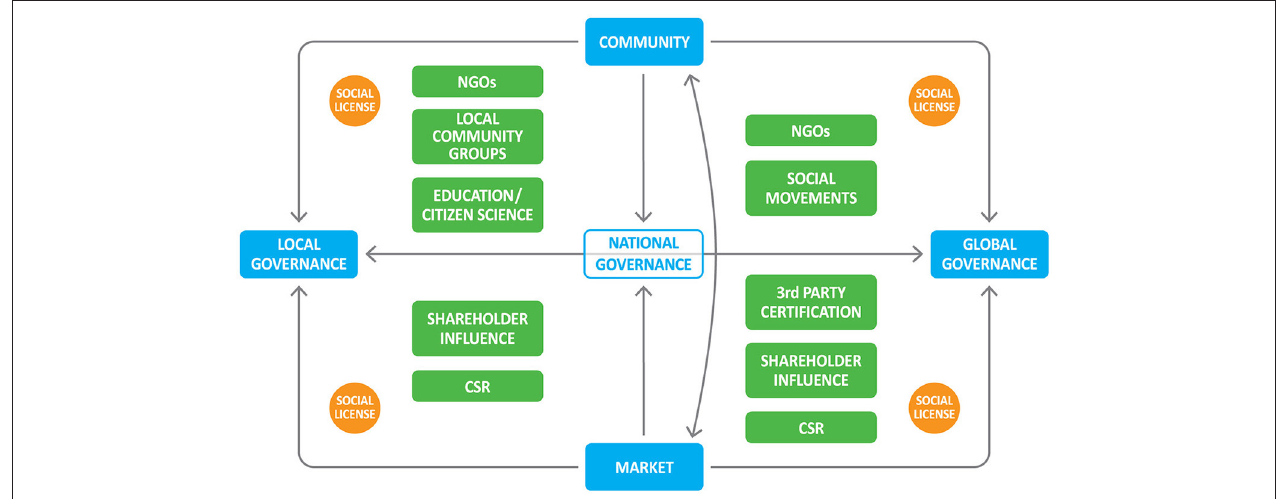
FIGURE 1 | A holistic governance approach to the reduction of plastic marine